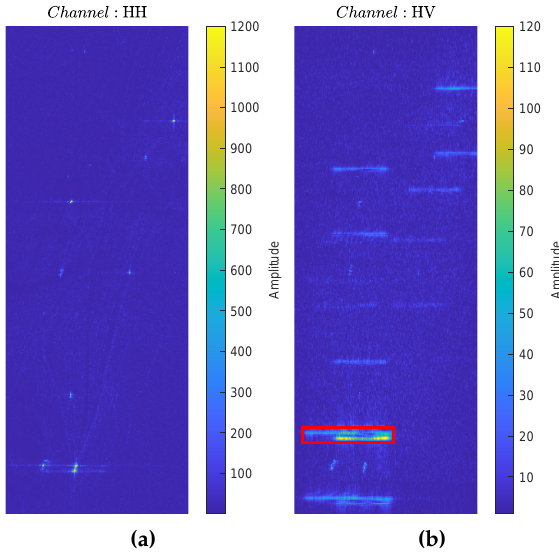
Figure 5. Simulations of the acquired HH and HV polarized images after polarization synthesis from hybrid quad-pol data based on parameters in Table 1. The HV and HH polarized data are simulated using chirp signals of up and down modulation rates respectively. Vertical is the azimuth direction. ( a ) Rebuilt HH polarized image with HV azimuth ambiguities. ( b ) Rebuilt HV polarized image with HH azimuth ambiguities. An example of smeared azimuth ambiguity is marked with red rectangle.